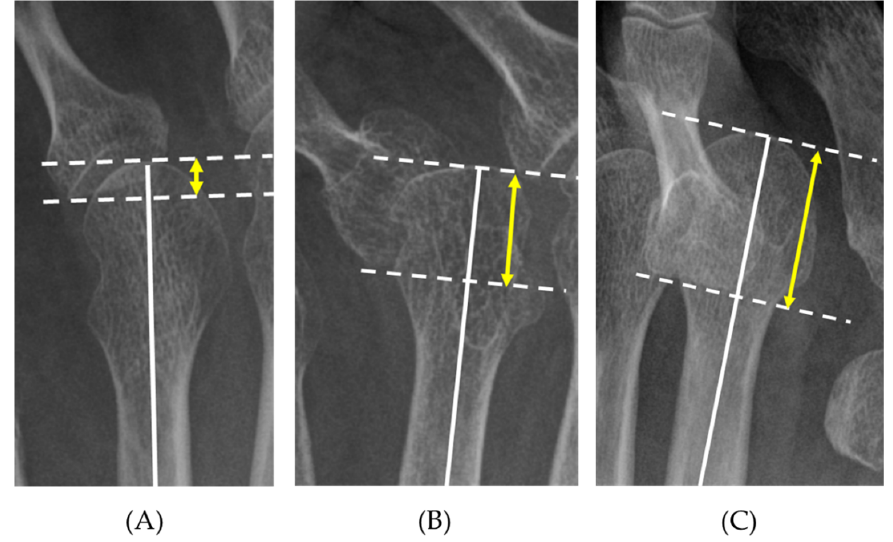
Figure 4. MOD grade. grade 1, 0 ≤ MOD < 5 mm ( A ), grade 2, 5 mm ≤ MOD < 10 mm ( B ), and grade 3, MOD ≥ 10 mm ( C ).